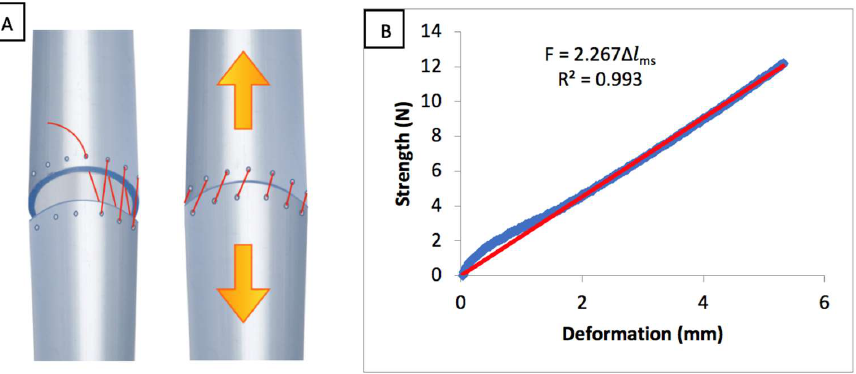
Figure 3. ( A ) Assembly of the two anastomosed jaws by the same technique used for the tracheas. ( B ) Force–deformation curve of the jaw-suture set (blue line). The trend line (in red) has a slope of 2.267 N · mm − 1 ( F : Force, ∆ l ms : suture and jaws deformation, R 2 : correlation coefficient).